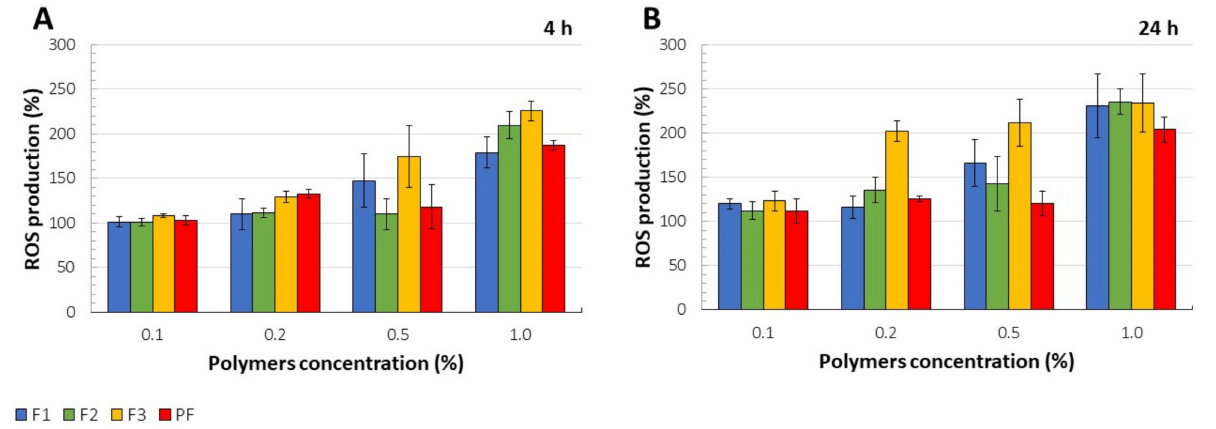
Figure 9. ROS production (%) for F1–F3 and placebo films (PF) after 4h ( A ) and 24 h ( B ) (mean ± SD, n = 4, p < 0.05).